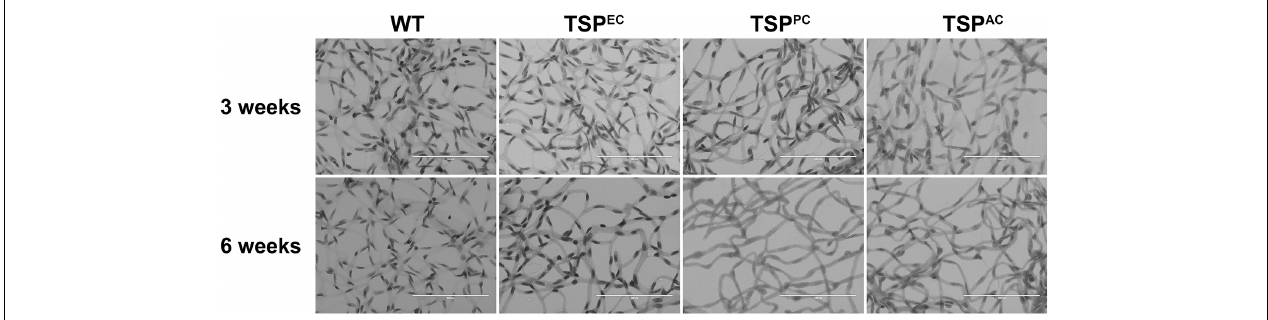
FIGURE 2 | Endothelial cell and pericyte numbers from mice conditionally lacking TSP1. Retinas from 3- and 6-week-old mice were prepared by trypsin digest and HE/PAS staining. Endothelial cell and pericyte numbers were determined per × 400 field of view. Scale bar = 100 µ m. Experiments were repeated with eyes from > 10 mice with similar results. Table 1 is the quantitative summarization of this